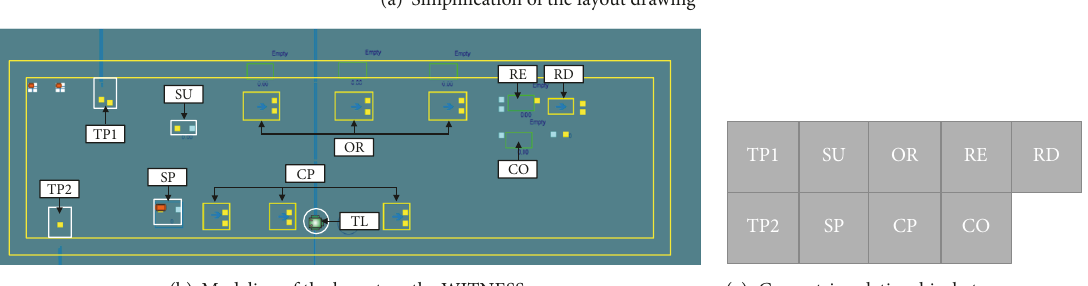
(c) Geometric relationship between process equipment derived from the simplified layout